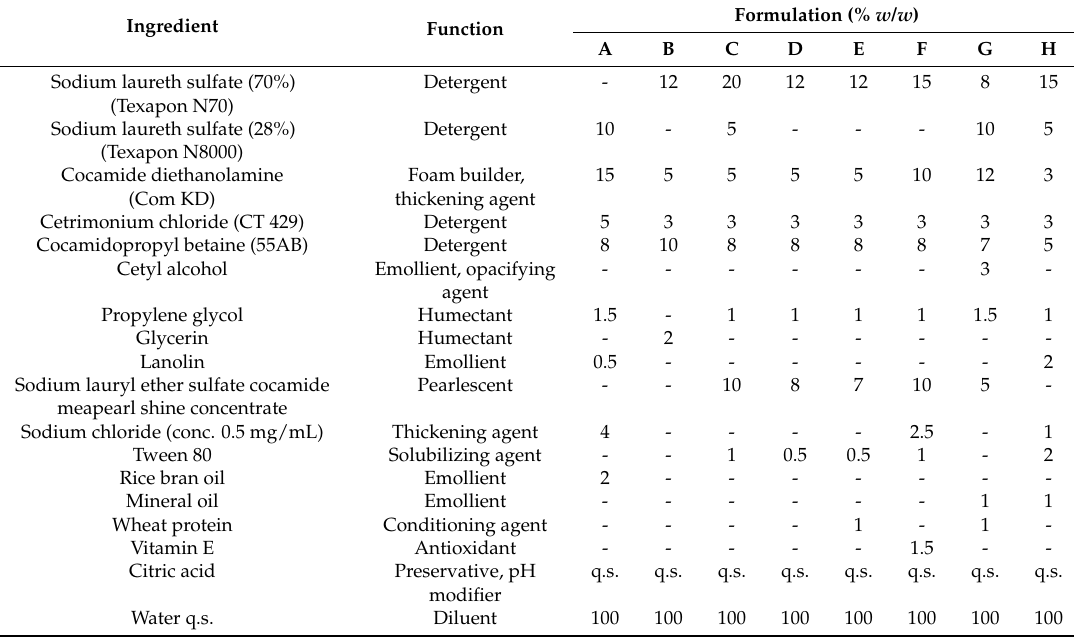
Table 1. Ingredients of shampoo formulations in this study.